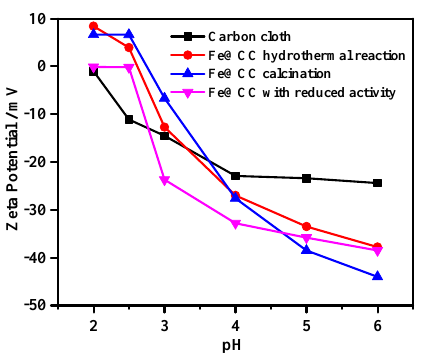
Figure 9. Zeta potential of the carbon cloth without treatment, Fe@CC after hydrothermal reaction at 200 °C, Fe@CC after calcination at 300 °C and Fe@CC with reduced activity.